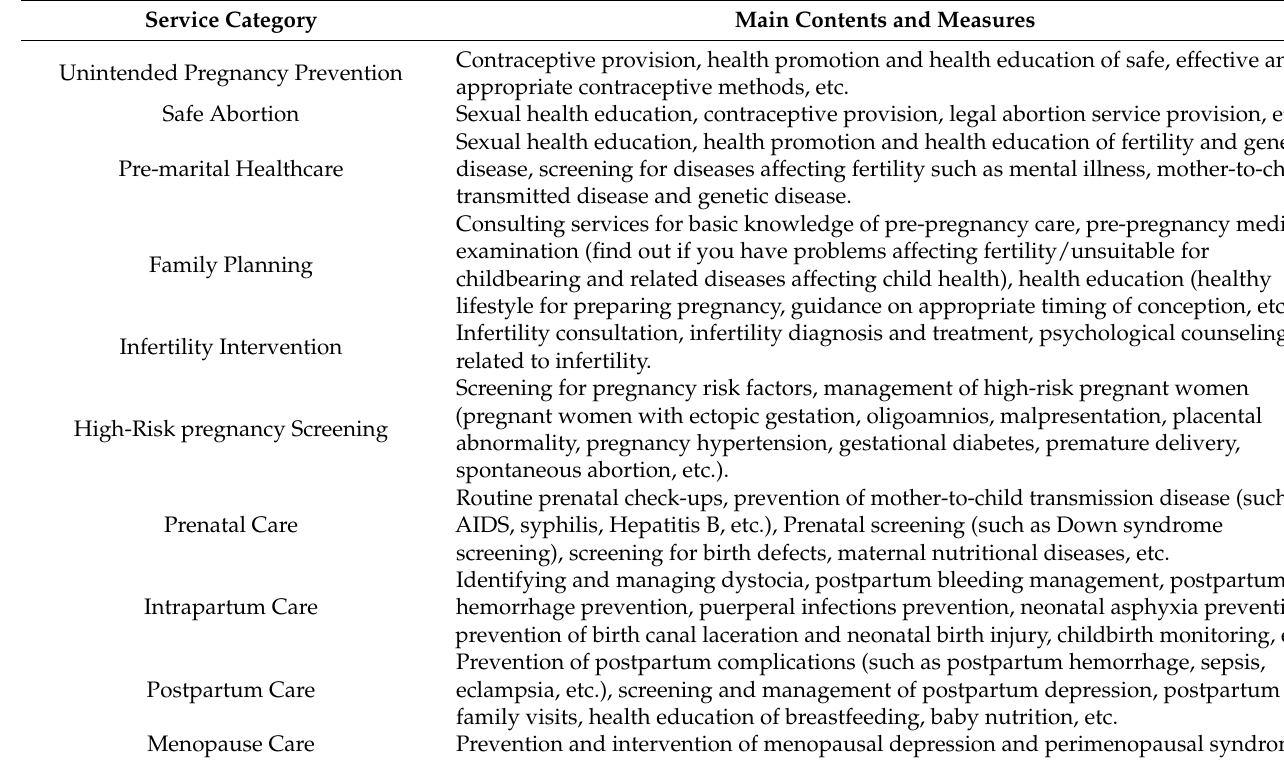
Table 1. Definition of 10 Categories of Essential Women’s Healthcare Services